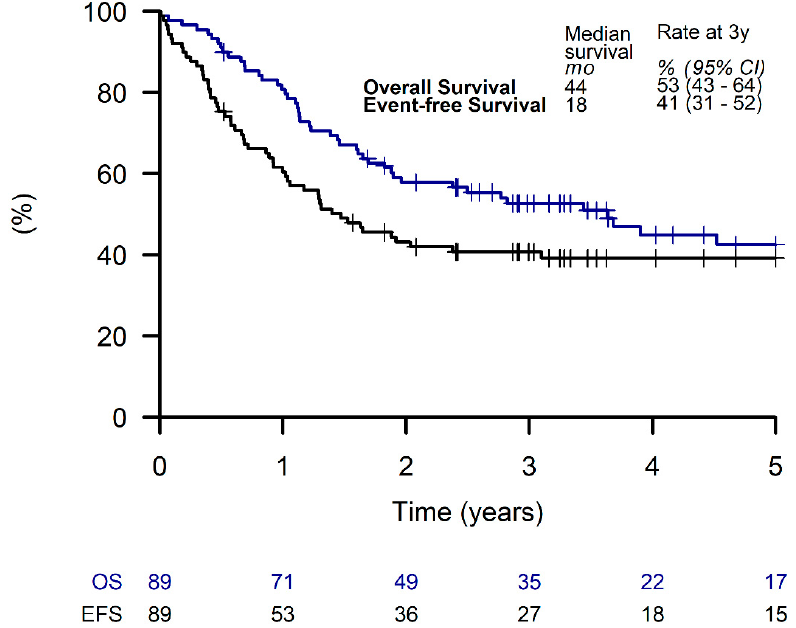
Figure 3. Overall survival and event-free survival of patients receiving a metronomic long-term maintenance therapy.